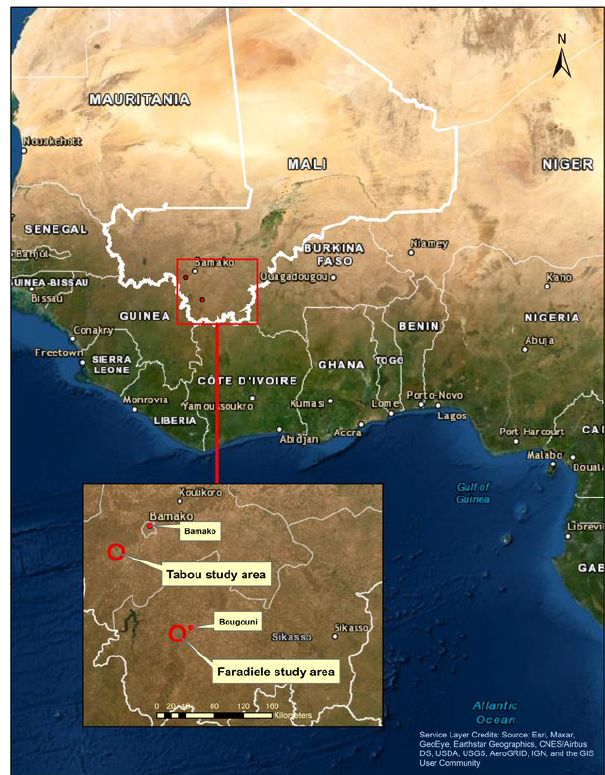
Figure 2. Study areas in southern Mali (figure by Scott